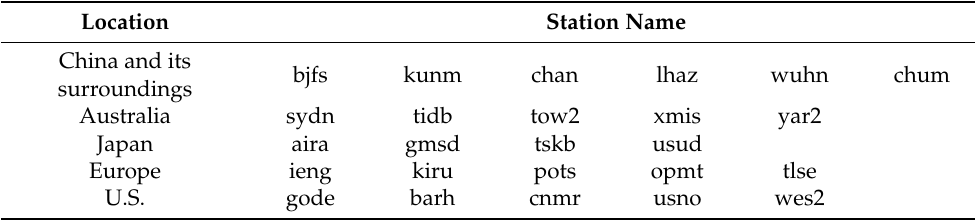
Figure 1. Distribution of 25 global CORS reference stations selected in the experiment. Table 1. The names of 25 CORS stations around the world selected in the